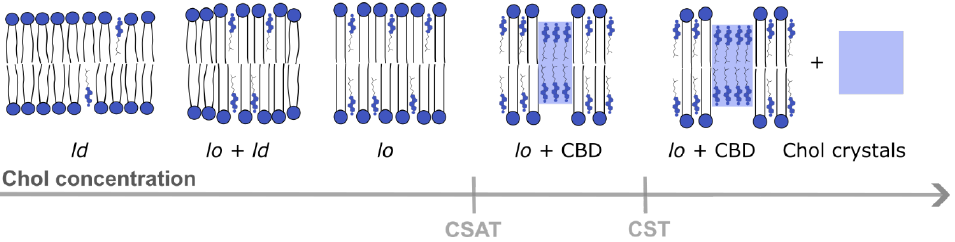
Figure 2. Different membrane domains ( l d —liquid-disordered domain, l o —liquid-ordered domain) formed in a lipid bilayer at different Chol concentrations from lower to higher content. CBDs start to form above the CSAT, and Chol precipitates in the form of Chol crystals above the CST level